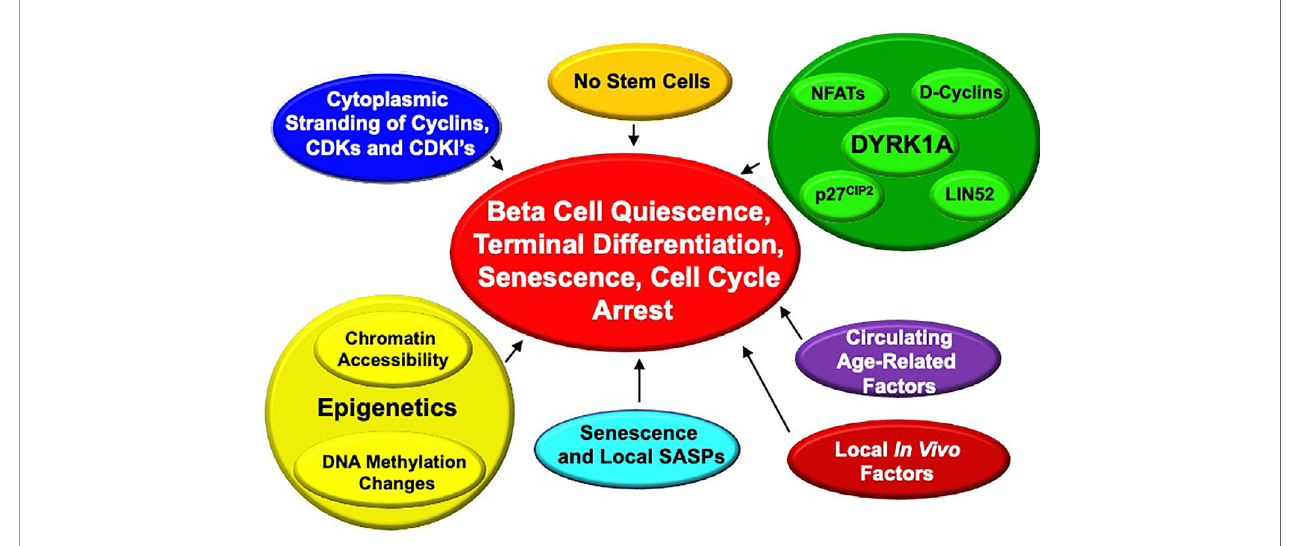
FIGURE 9 | Proposed Mechanisms for Enforced “ Quiescence ” , “ Terminal Differentiation ” or “ Senescence ” in Adult Human Beta Cells. See text for